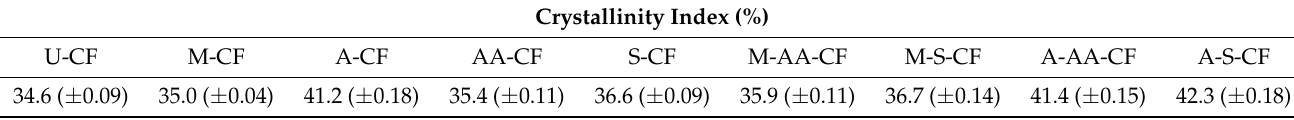
Figure 6. XRD spectra of coir fibers. Table 2. Crystallinity index values of coir fibers.